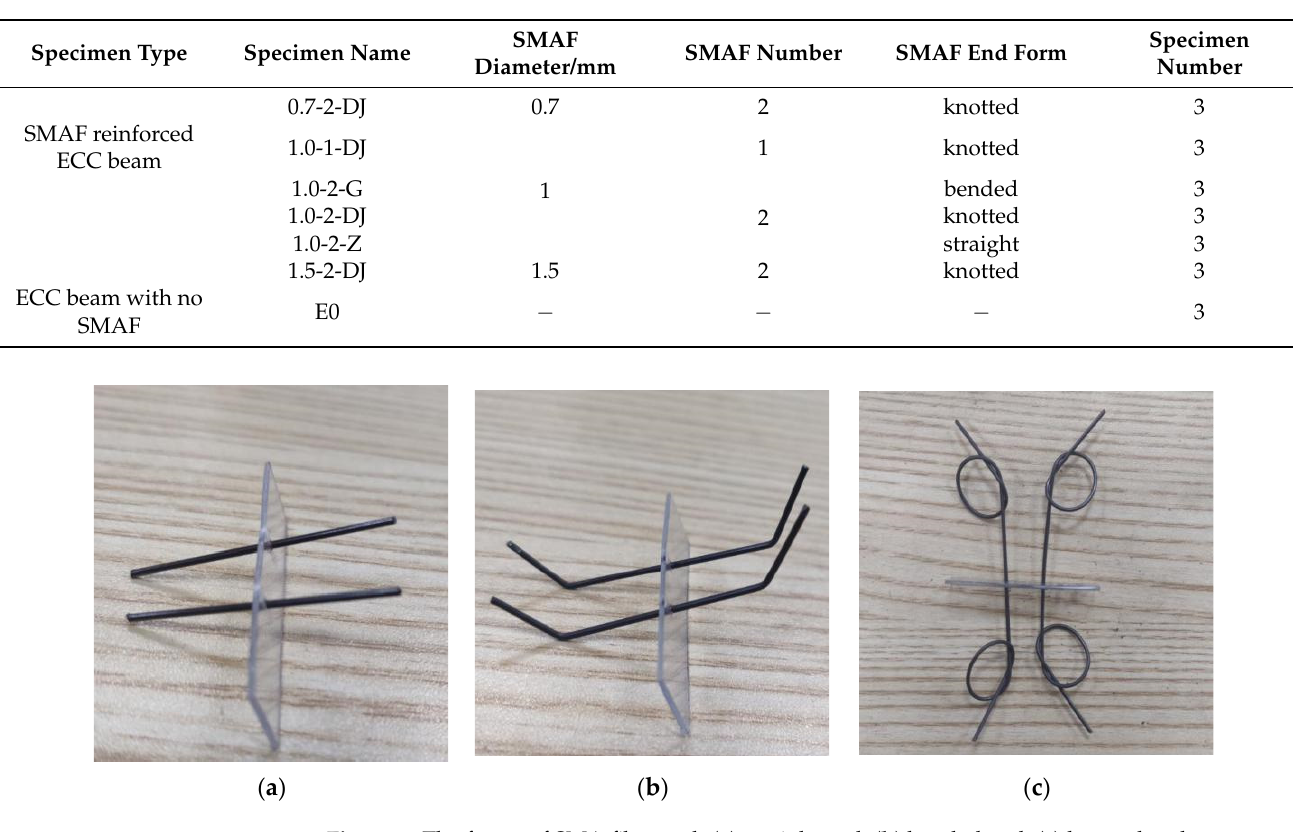
Figure 6. The forms of SMA fiber end: ( a ) straight end; ( b ) bended end; ( c ) knotted end.